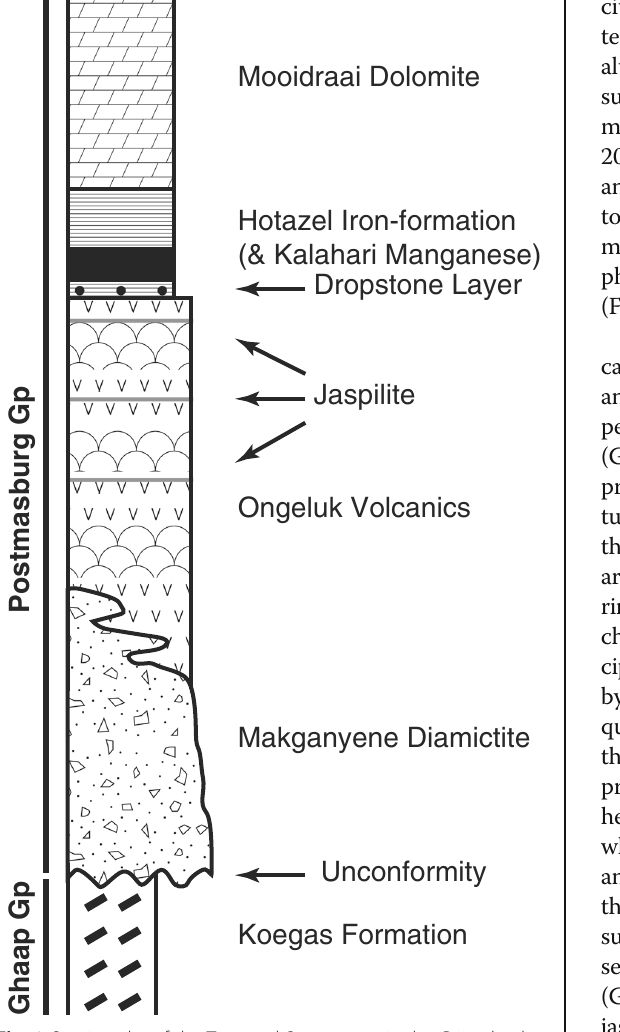
Fig. 2 Stratigraphy of the Transvaal Supergroup in the Griqualand West region, South Africa. The relationship among the Ongeluk Formation, the Makganyene diamictite, and the overlying Hotazel Formation are shown (after Kirschvink et al. 2000). The Ongeluk Formation (~ 500 – 1000 m thick) conformably overlies the Makganyene Diamictite (~ 3 – 70 m thick) and underlies a dropstone layer at the bottom of the Hotazel Formation (~ 100 – 250 m